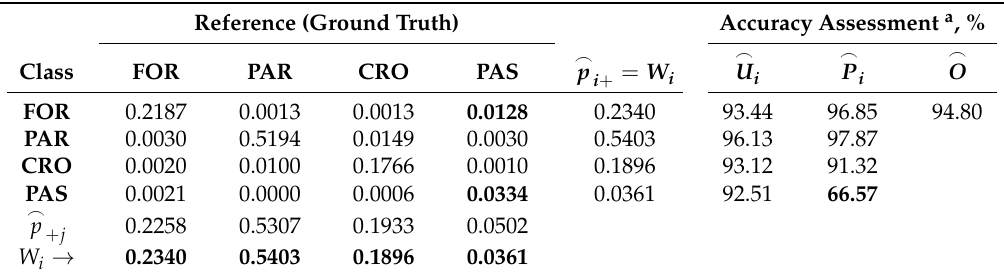
Table 6. Population error matrix of the four classes with cell entries ( p ij ) expressed regarding the estimated proportion of the area .